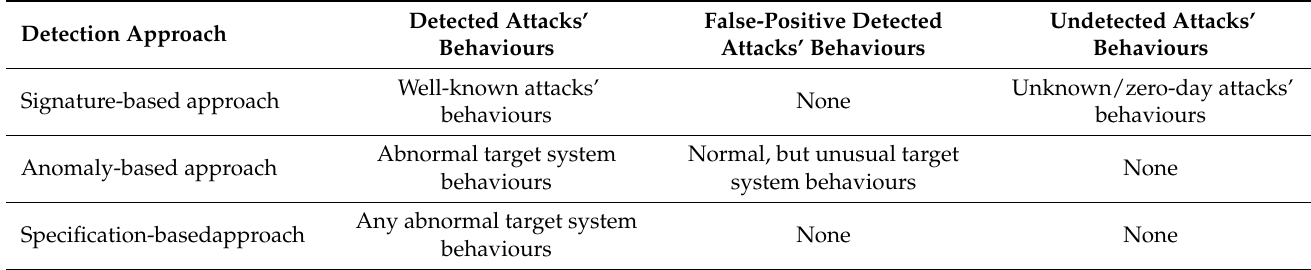
Table 1. The difference between detection